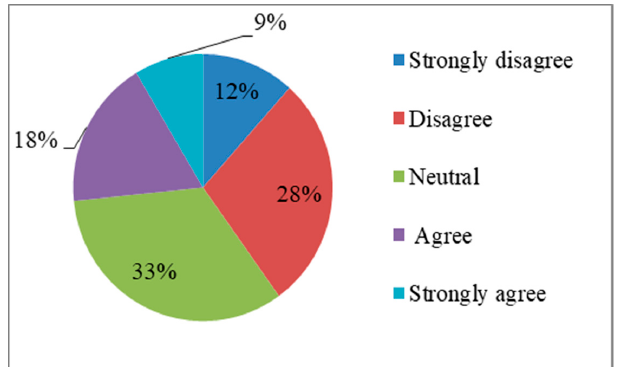
Figure 5. Another major earthquake may occur in the next 10 years.